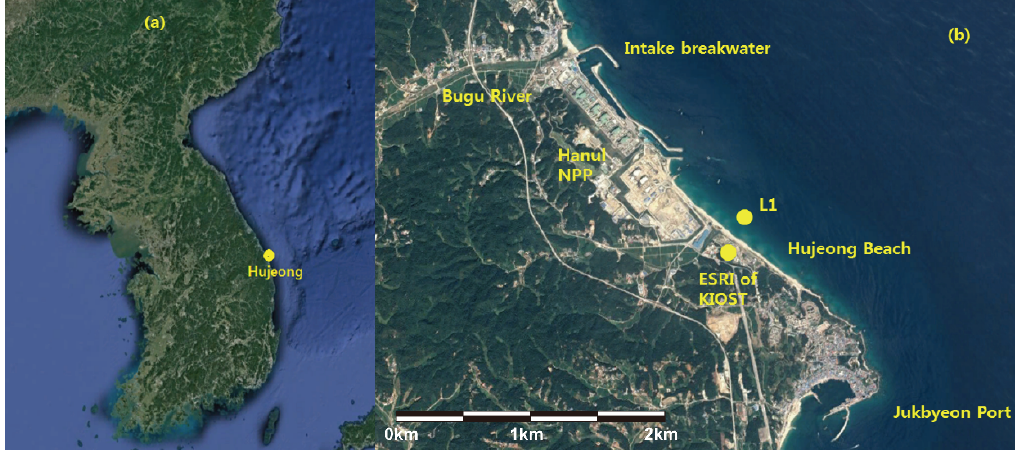
Figure 1. ( a ) Location of Hujeong Beach; ( b ) map of Hujeong Beach with location of the video monitoring system (L1). This figure is taken from [11].